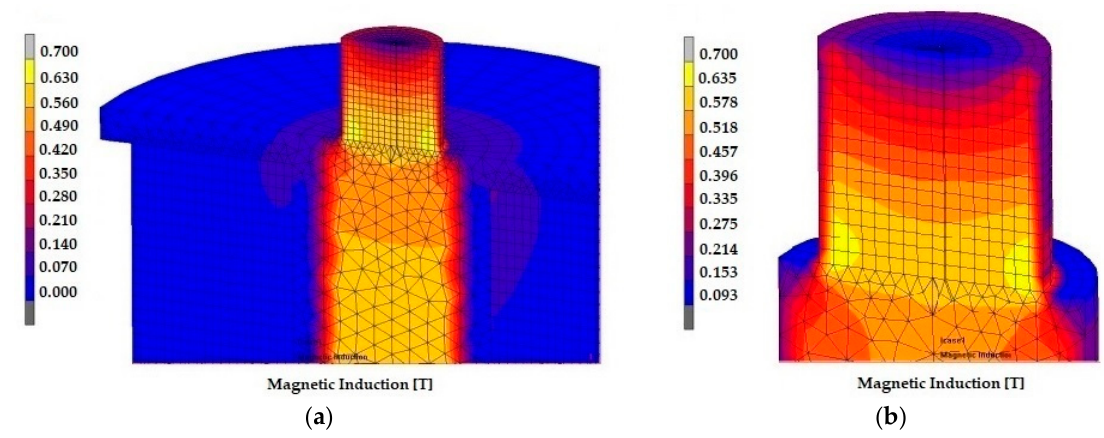
Figure 6. ( a ) Magnetic induction distribution on the top portion of the configuration exposing the magnet and MRE sample ( b ) closure view.